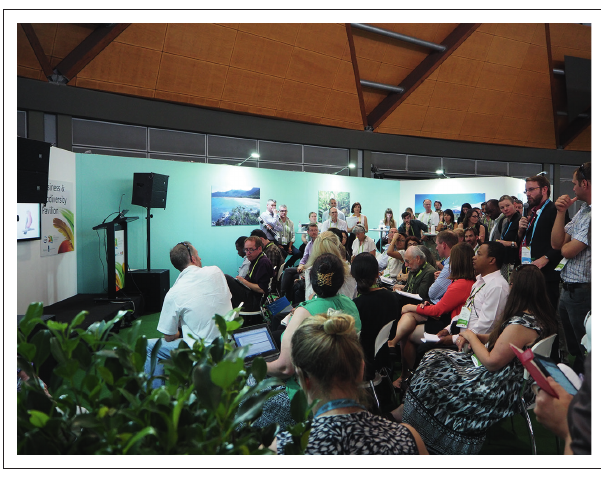
FIGURE 3: Congress delegates discuss biodiversity offsets and their application in different